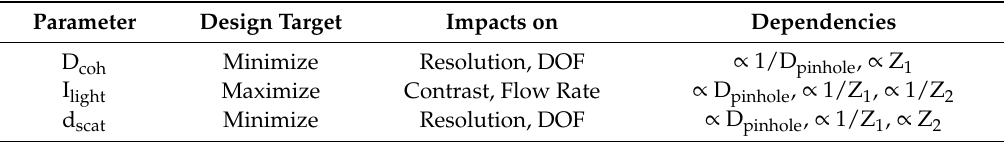
Table 1. Critical Parameters of the lens-less